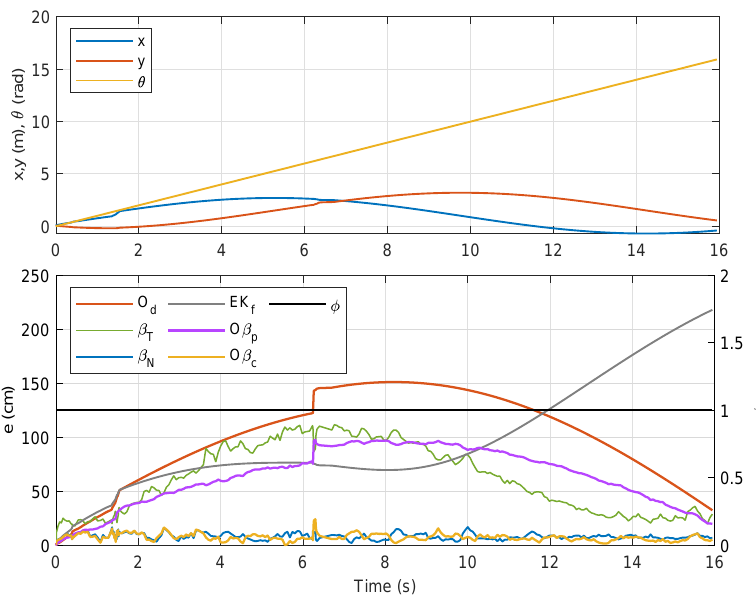
Figure 21. Trajectory 4: Position of NSBot2 in terms of x , y and θ based on odometry ( top ); and temporal localization-error analysis ( bottom